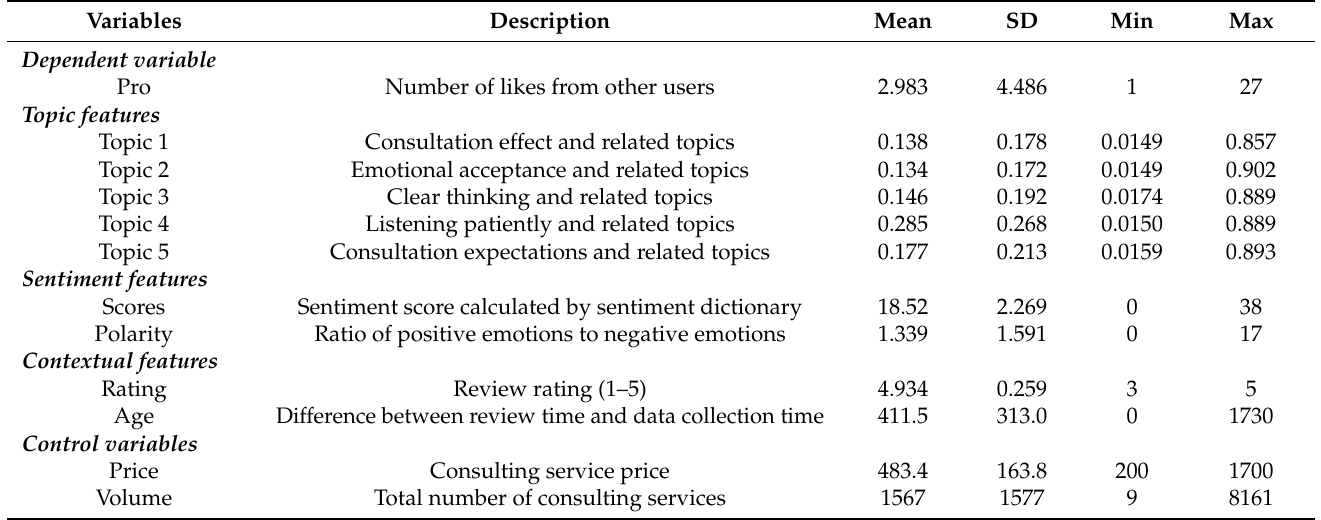
Table 4. Descriptive statistical analysis of